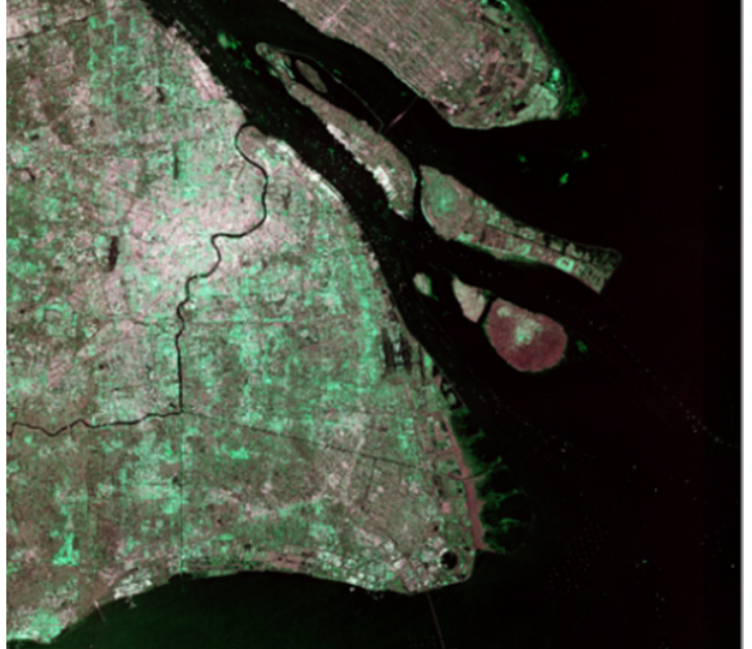
Figure 3. Example of 8-bit pseudo-color enhanced product after preprocessing.